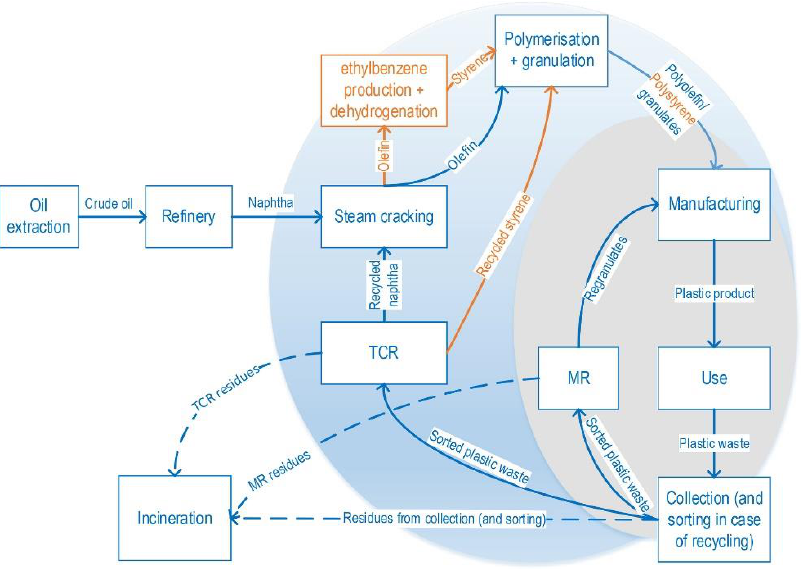
Figure 1. The linear and circular economy based on PS. Reprinted with permission from ref. [4].